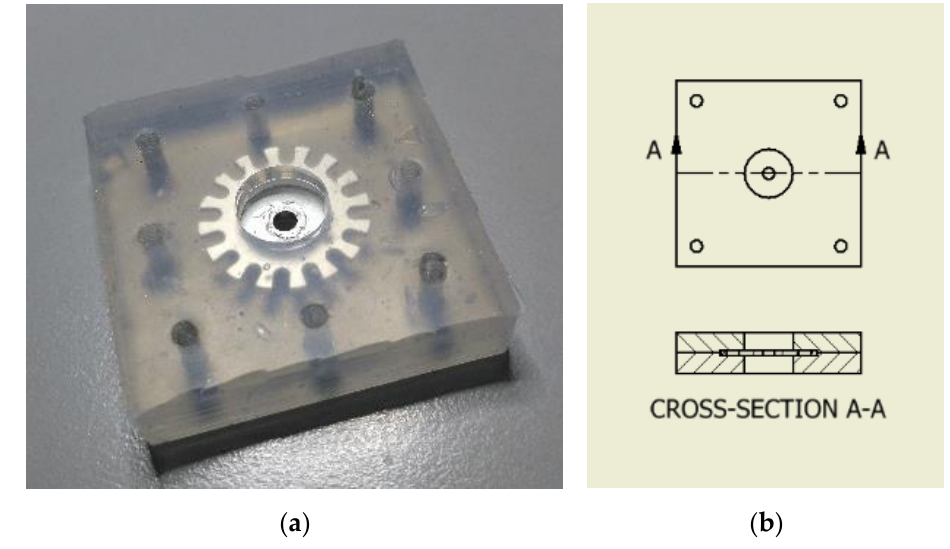
Figure 4. ( a ) Polymer with encapsulated movement carrier, encapsulated version 1 ( b ) Polymer with movement carrier, cross-section, version 1.